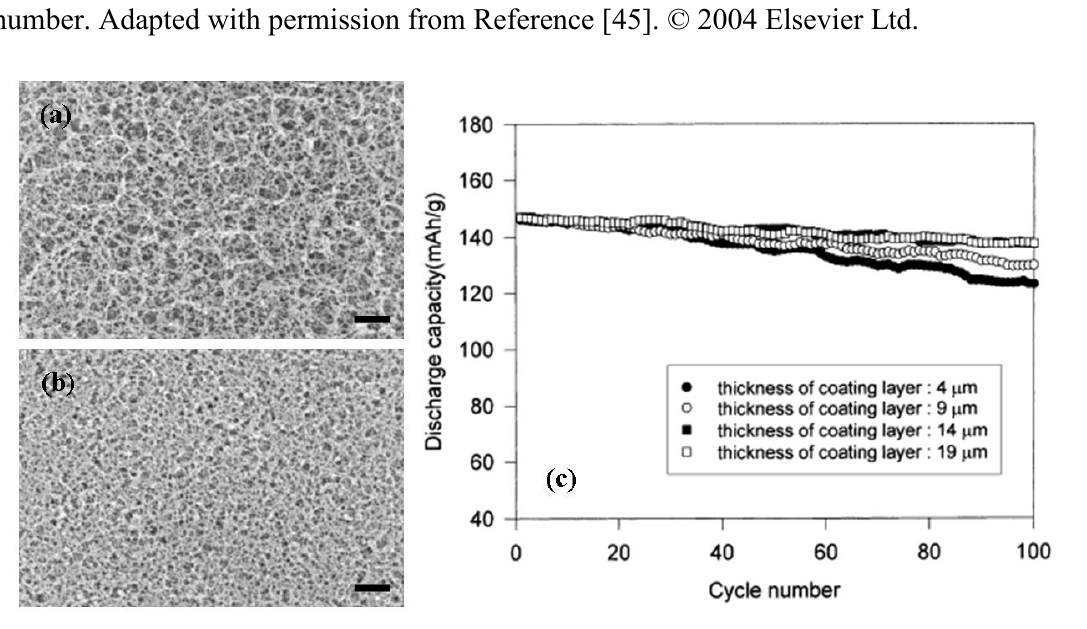
Figure 1. SEM images of polymer-coated PE separators prepared with (a) 1 wt% and (b) 3 wt% of polymer concentrations (scale bar: 5  m). (c) Discharge capacity of LIPB